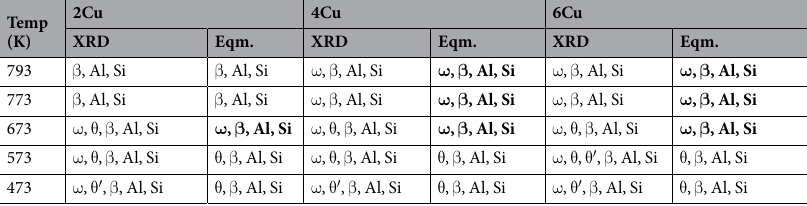
Table 2. Detected phases from XRD analysis and corresponding estimated equilibrium phases at different temperatures; bold faced letter indicate confirmed presence of equilibrium ω -phase in different